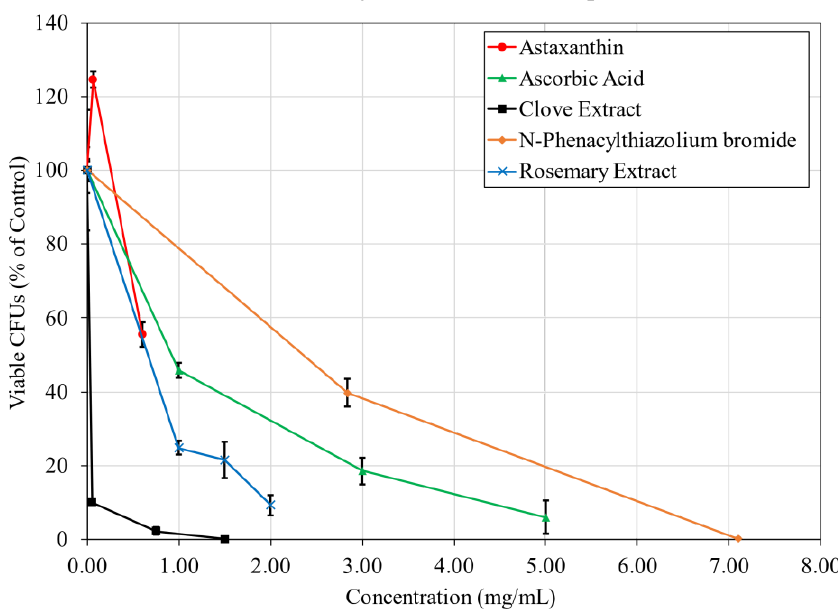
Figure 2. Growth Inhibition. Viable S. aureus CFUs after 24 h of incubation under planktonic conditions with additives. n = 3. Mean ± Standard Deviation.